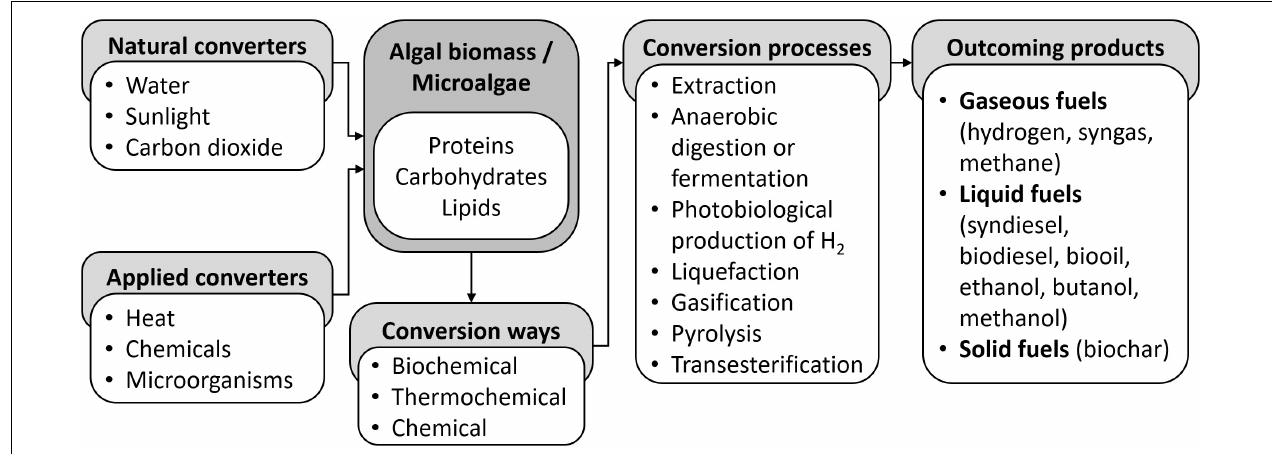
FIGURE 2 | Schematic overview of conversion of algal biomass into economically significant products – biofuels, indicating the major converters, conversion ways and processes (Sikarwar et al., 2017; Kumar et al.,